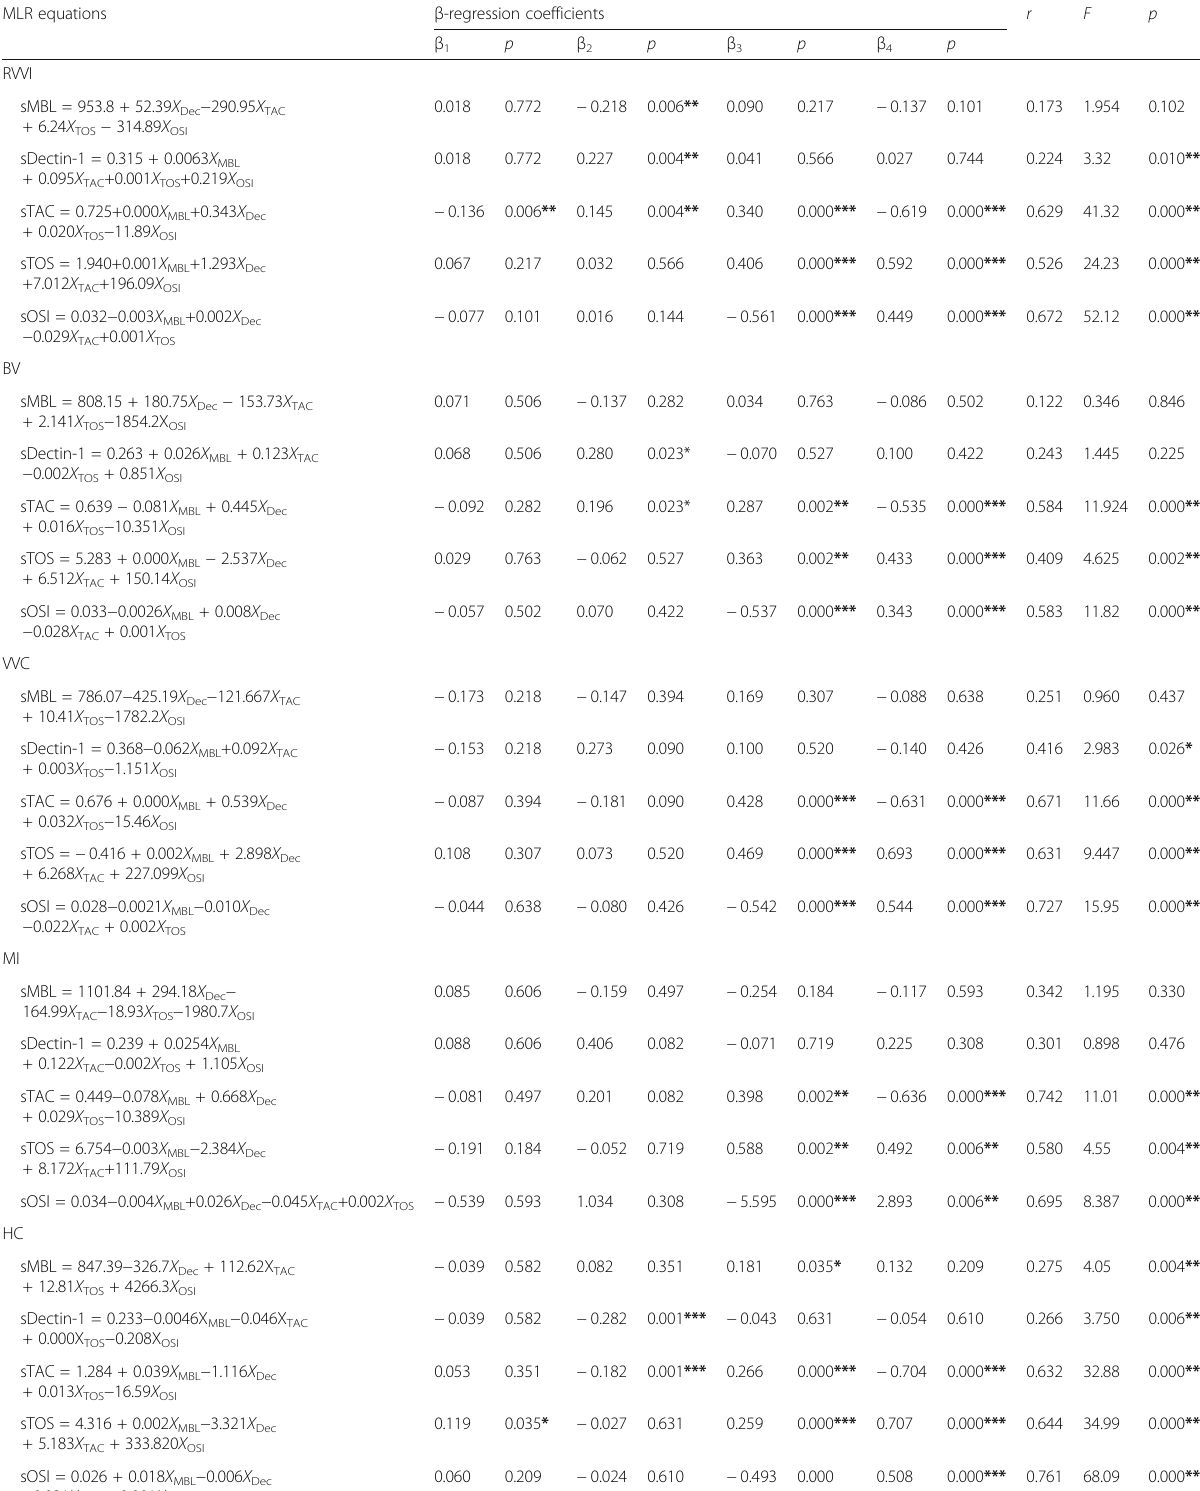
Table 4 Multiple linear regression analysis of serum biomarkers in RVVI, RVVI types and